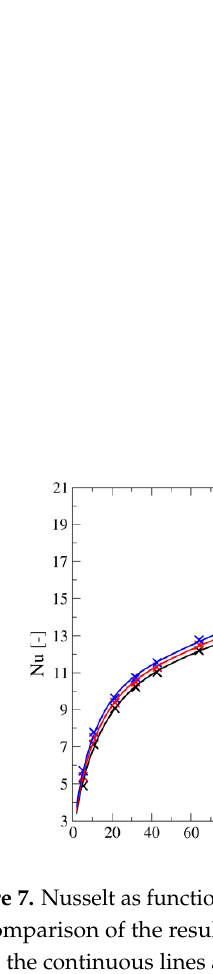
Figure 6. SiSiC lattice fabricated with replica method.